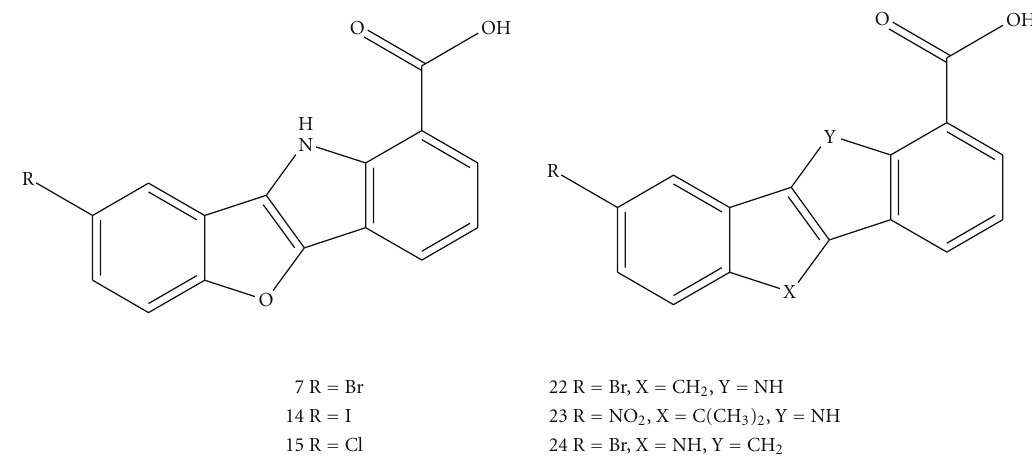
Figure 3: Structures of the highly bladder (versus aorta) selective benzofuroindole compounds synthesized by Butera et al. [24].